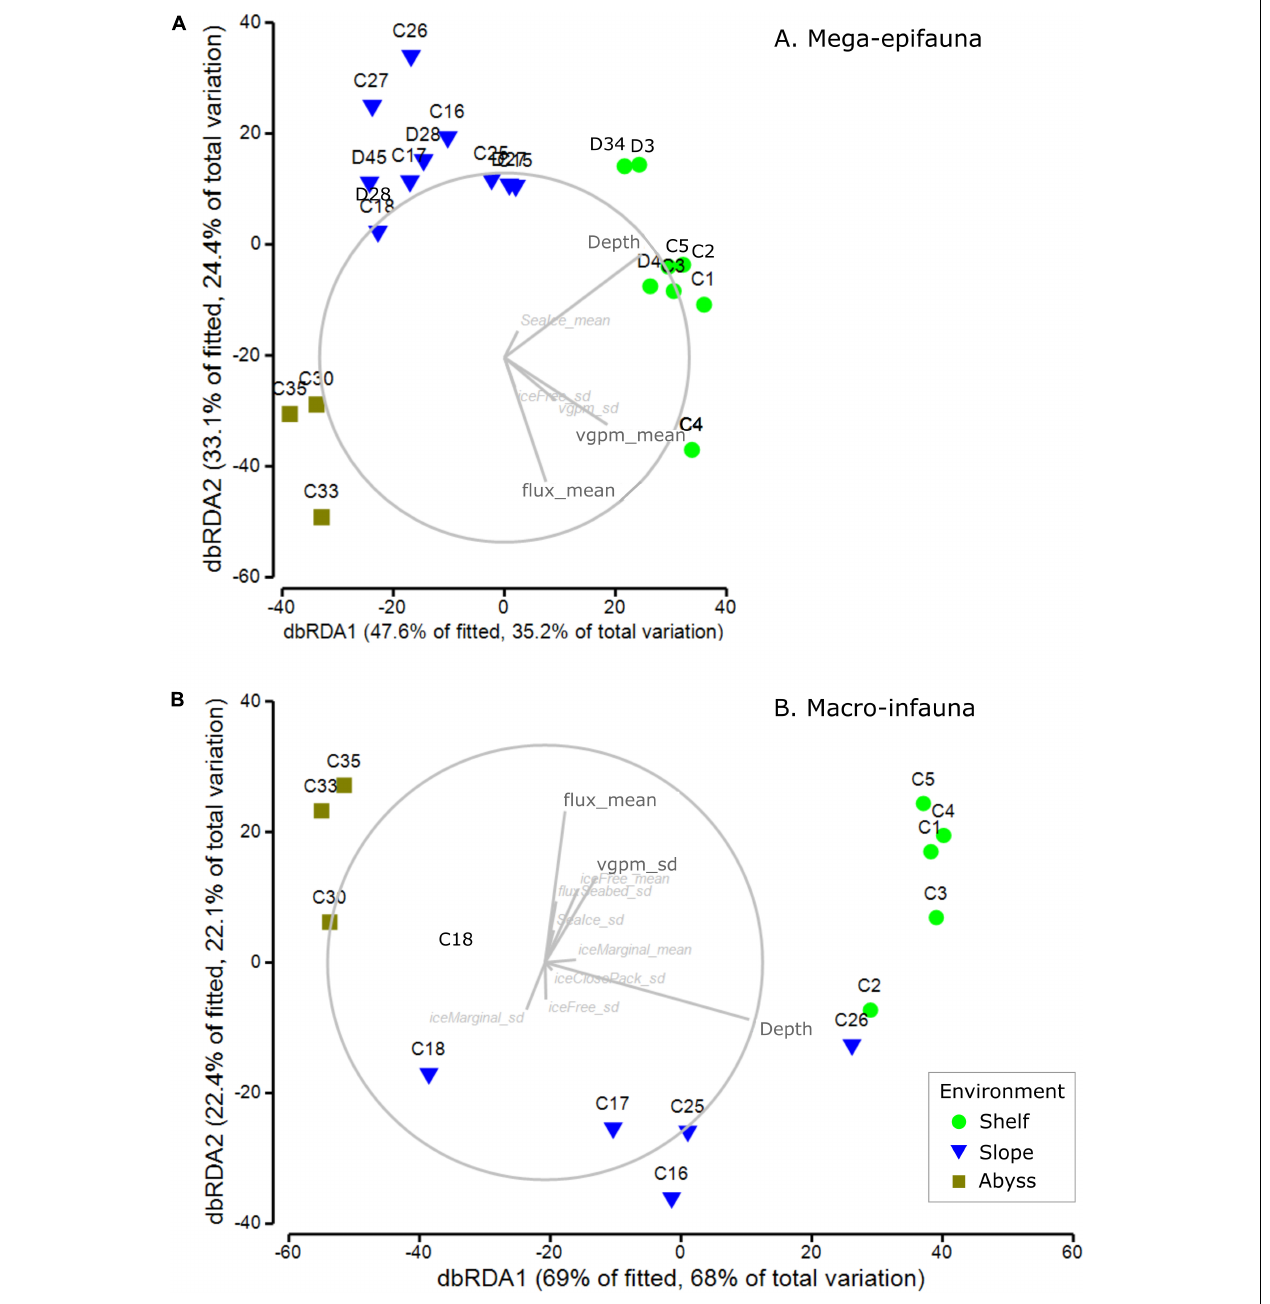
FIGURE 8 | dbRDA ordinations of abundance weighted feeding traits of (A) mega-epifaunal and (B) macro-infaunal, at each site. Vector overlays indicate the strength and direction of the relationships between sea ice- and productivity-associated environmental variables on the dispersion of samples in the ordination. DistLM outputs are provided in Supplementary Tables 7 , 8 ,